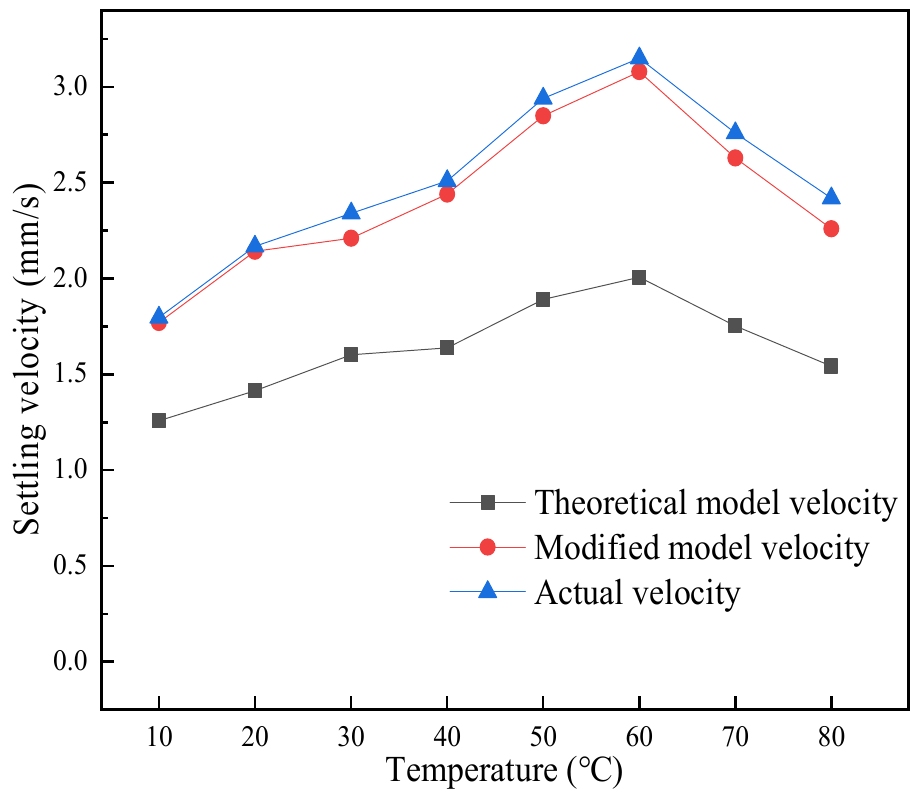
Figure 9. Comparison between model and actual settling velocity.